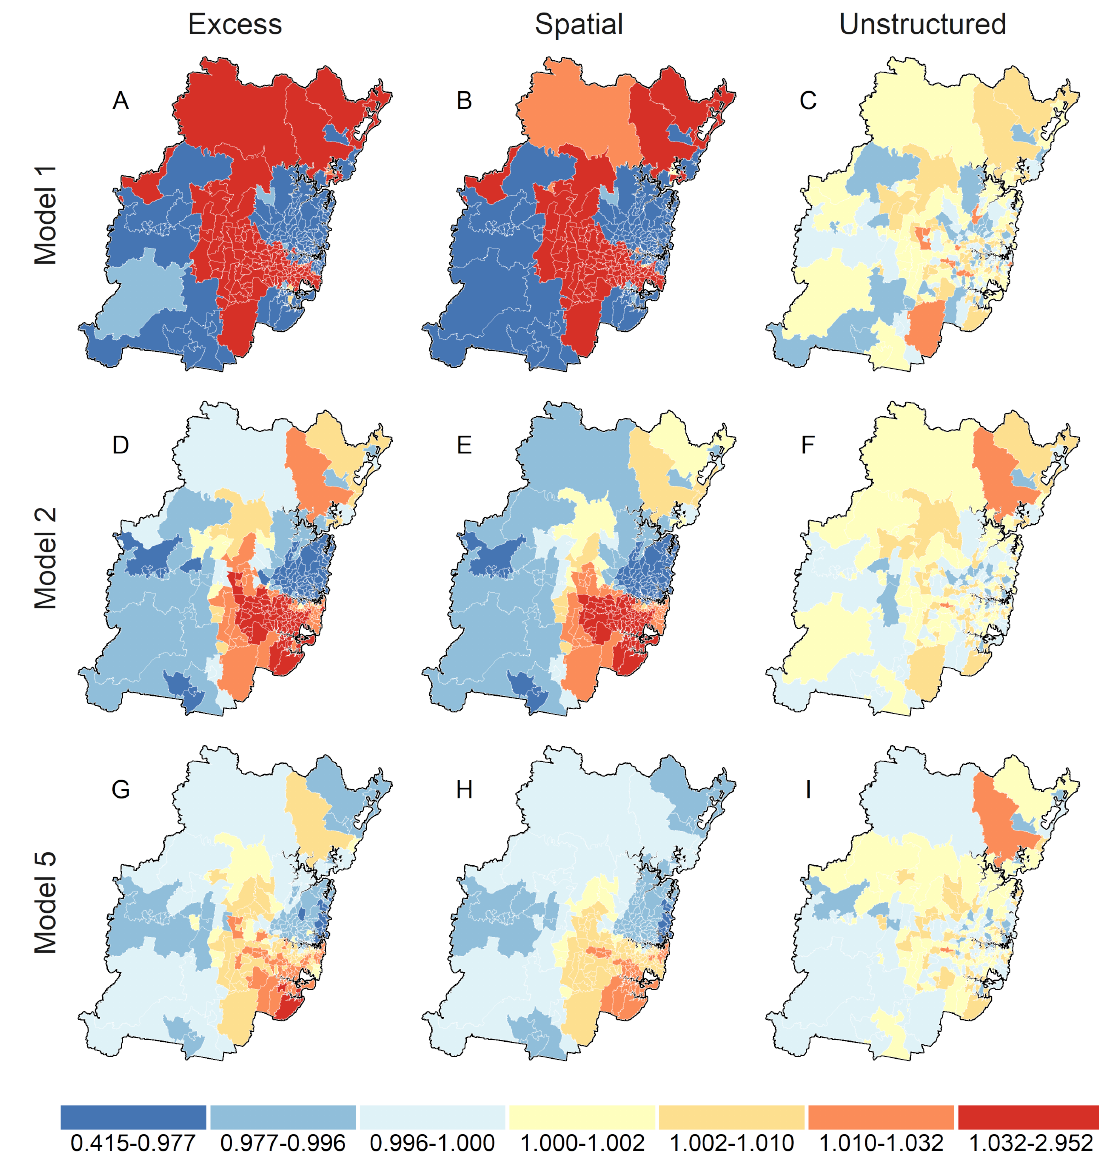
Figure 1. Total, Spatial and Unstructured prevalence ratios for Sydney postal areas. Total prevalence ratios were derived by exponentiating the sum of the log odds for the s and u random effects; Spatial and Unstructured prevalence ratios were obtained by exponentiating the log odds of the individual s and u components, respectively. Total, Spatial, and Unstructured prevalence ratio estimates are reported in maps A – C for model 1, maps D – F for model 2, and maps G – I for model